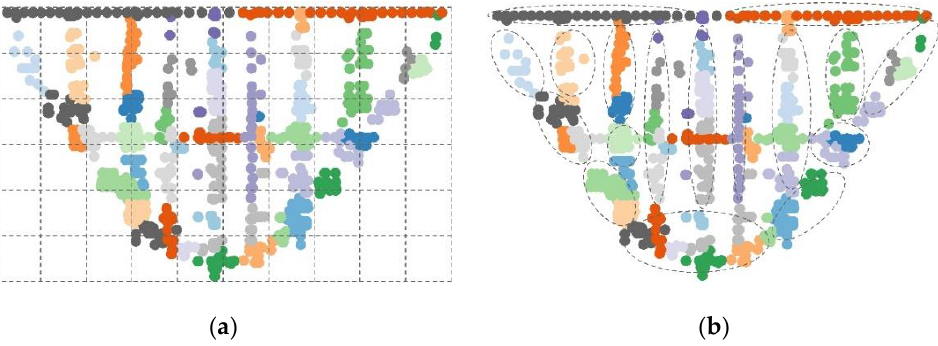
Figure 1. Network partition results for dam safety monitoring system ( a ) gridded partition results with a mechanical model; ( b ) partition results with the network partitioning algorithm (NPA) based on spatial-temporal features.